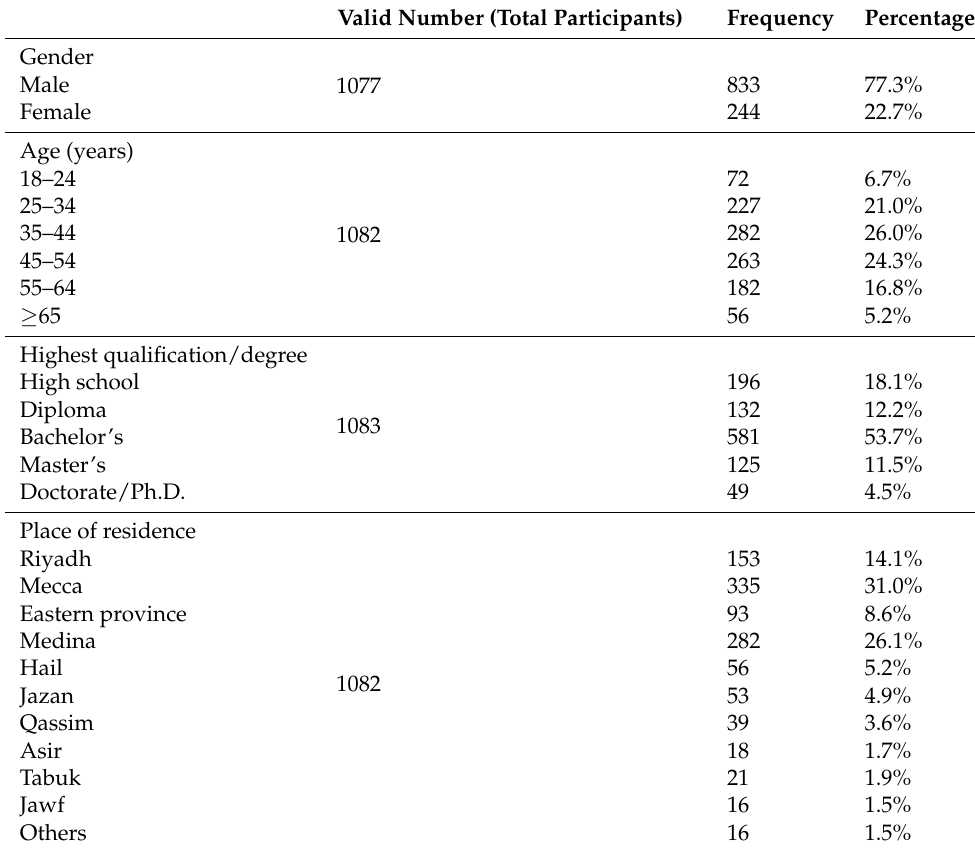
Table 1. Demographic characteristics of the participants ( n =